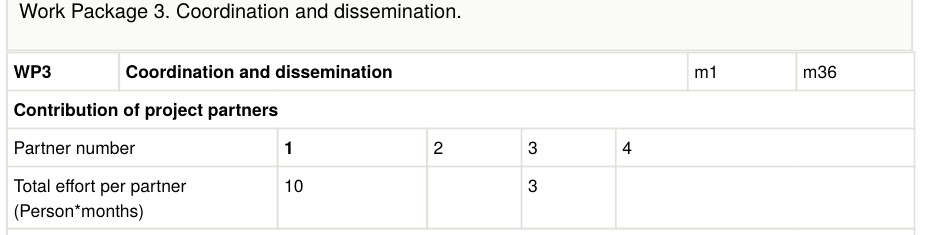
Work Package 3. Coordination